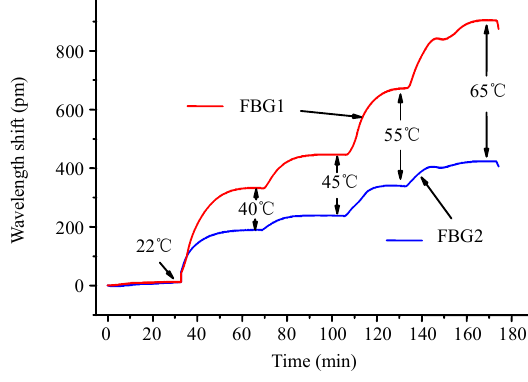
Fig. 7 Time-history curve of the